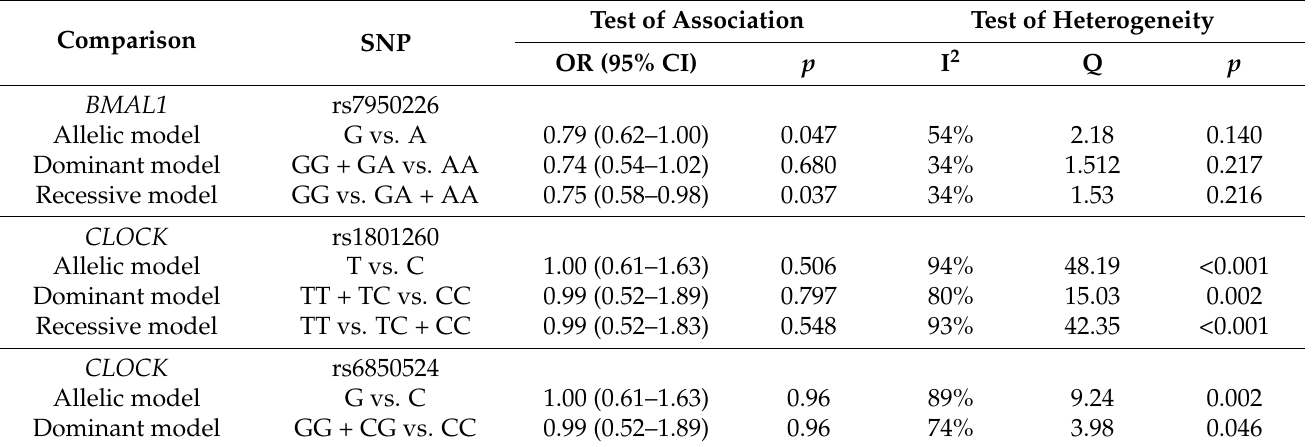
Table 3. Meta-analysis results of the BMAL1 rs7950226 and CLOCK rs1801260 and rs6850524 poly- morphisms and MetS